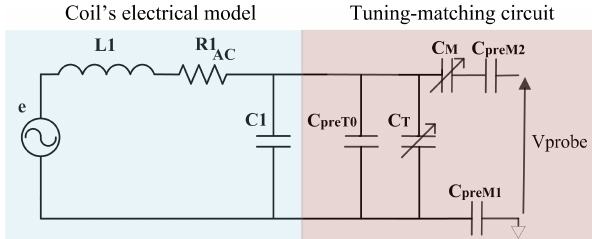
Figure 6. Electrical circuit of the coil plus the tuning–matching